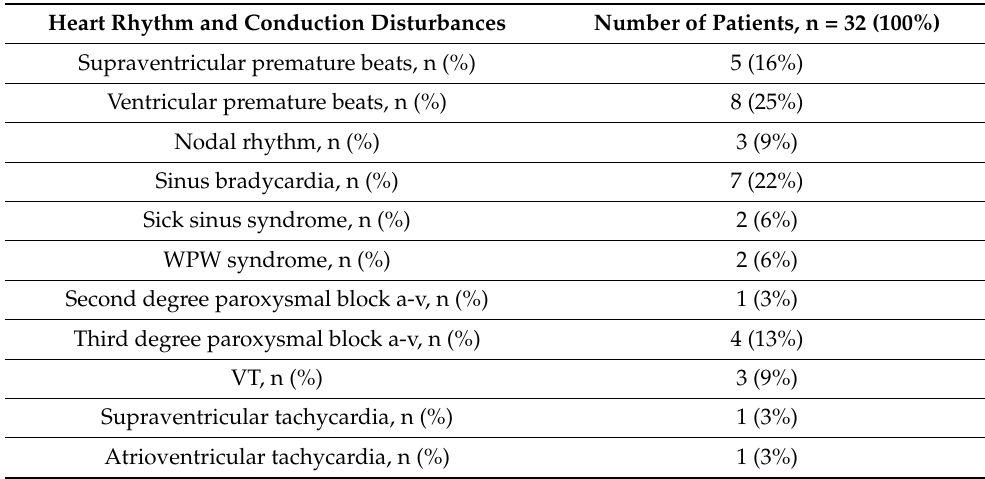
Table 2. Heart rhythm and conduction disturbances in the studied group of children.